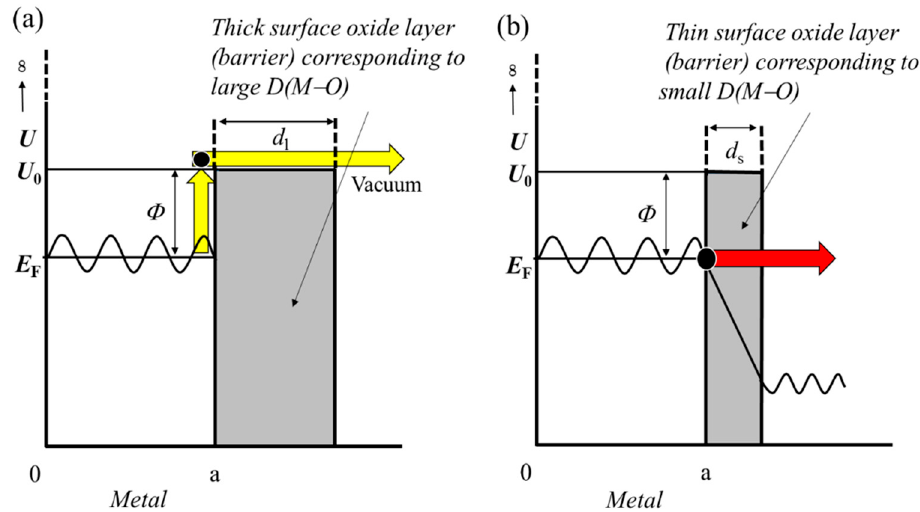
Figure 19. Model of scheme for TriboEE from a metal sample covered with surface oxide layer consisting of large ( a ) and small ( b ) D(M–O) values during sliding contact with a polytetrafluoroethylene (PTFE) rider, where an external electric field is caused. ( a ) Electrons pass over the top of the barrier (Schottky effect), where the change in work function occurs because of a well-known image force. ( b ) Electrons tunnel through the barrier (tunnel effect).